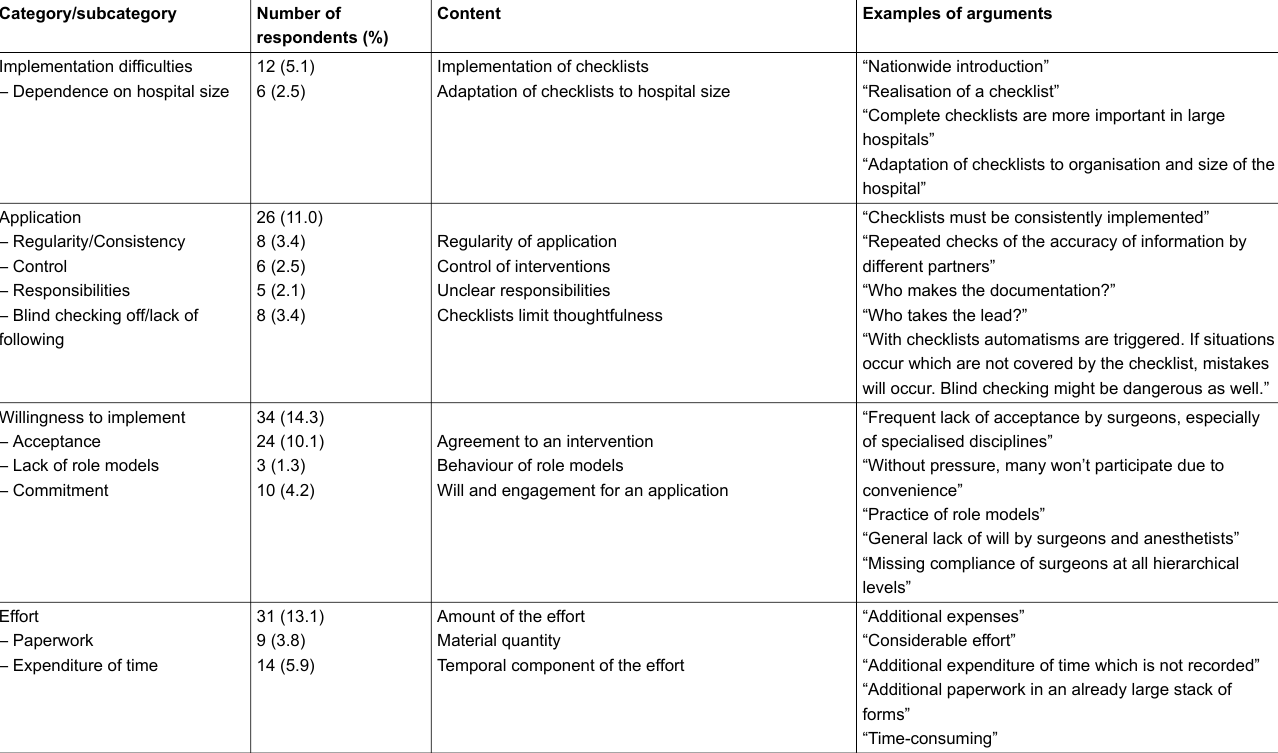
Table 4: Examples of arguments for the disadvantages of introducing and implementing surgical safety checklists and the number of respondents per category (n = 237). Category/subcategory Number of respondents